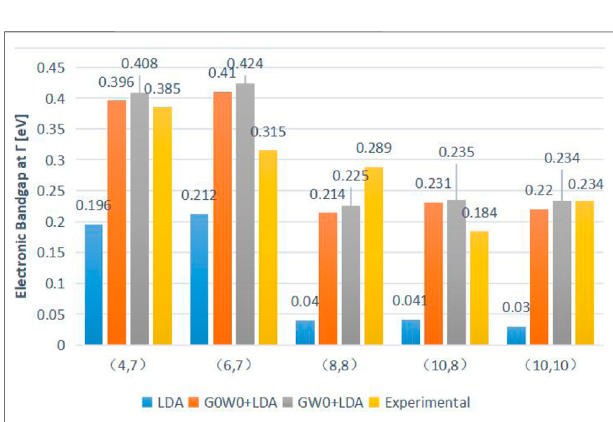
FIGURE15| Simulatedbandgapsof(4,7),(6,7),(8,8),(10,8),and(10,10) InAs/GaSbSLsinthe fi rstBrillouinzoneusingtheDFT – LDA,G0W0+LDA,and GW0+LDA approximations with the corresponding experimental values. GW+LDA lead to results in good agreement with the